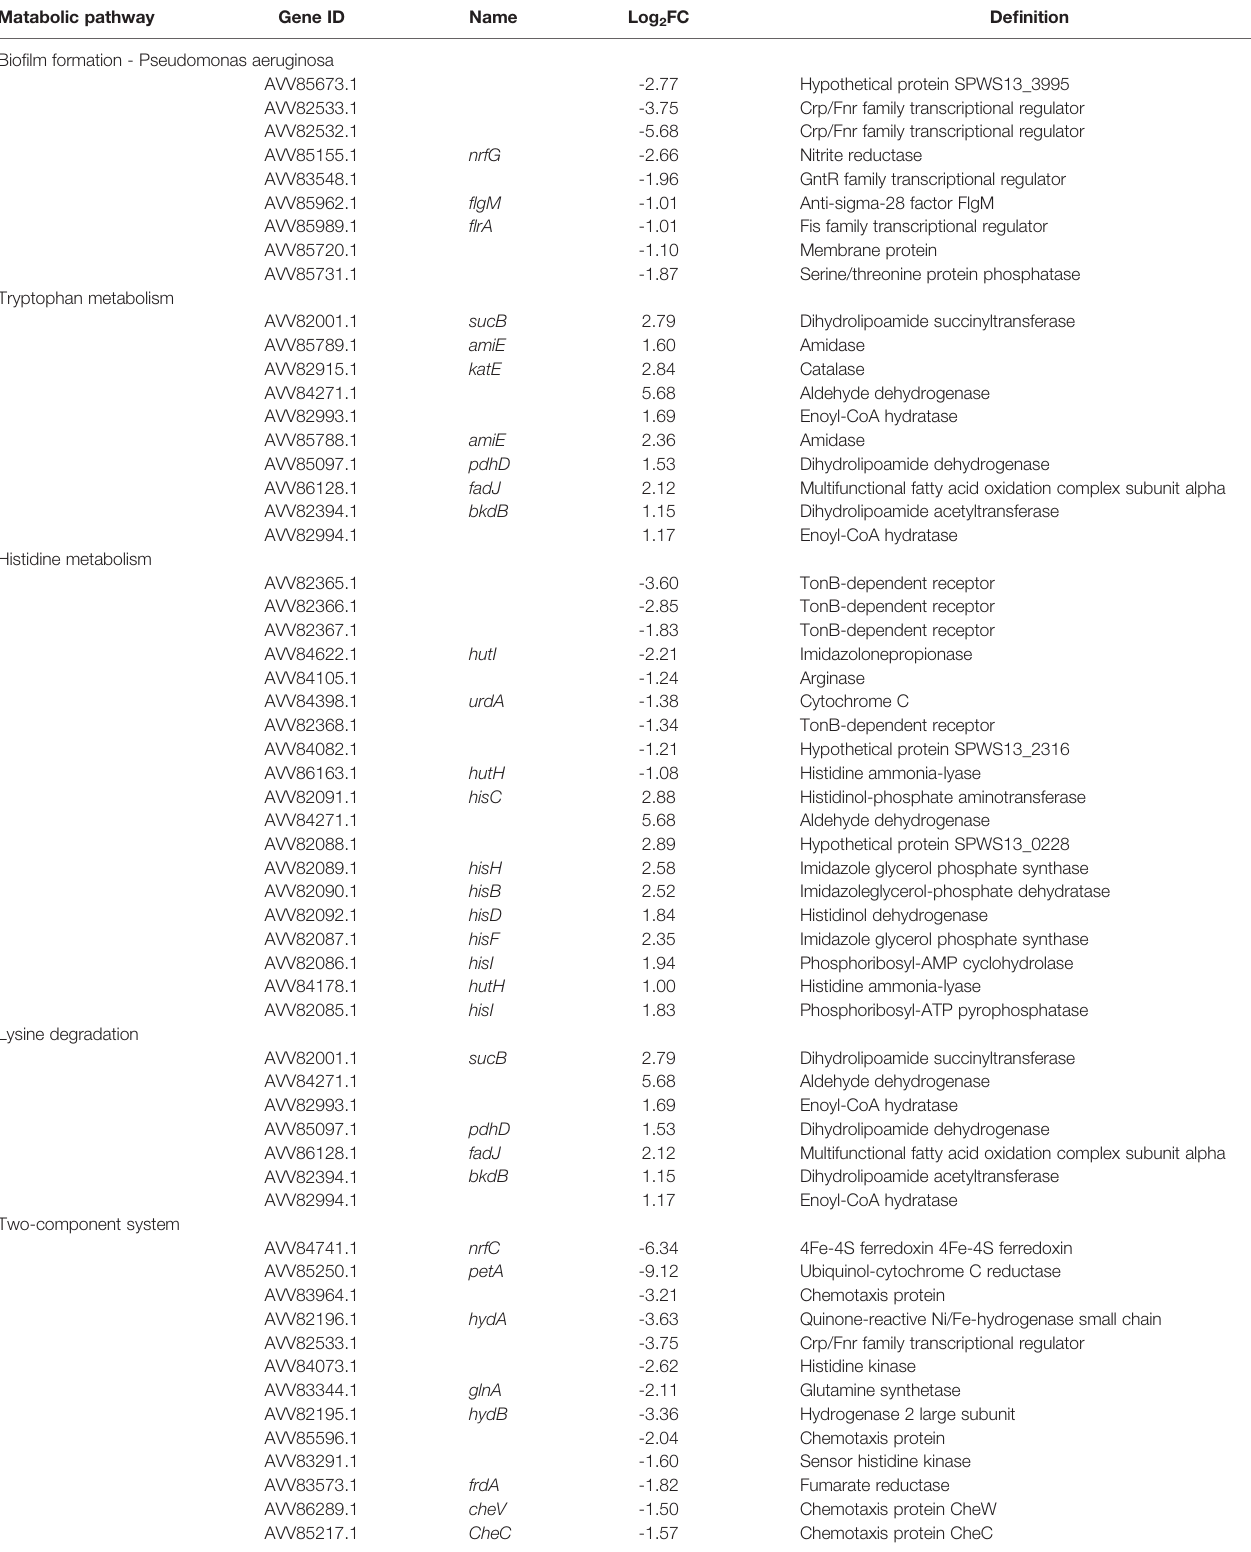
TABLE 2 | The major DEGs in bio fi lm cells of S. putrefaciens WS13 induced by the cold stress. Matabolic